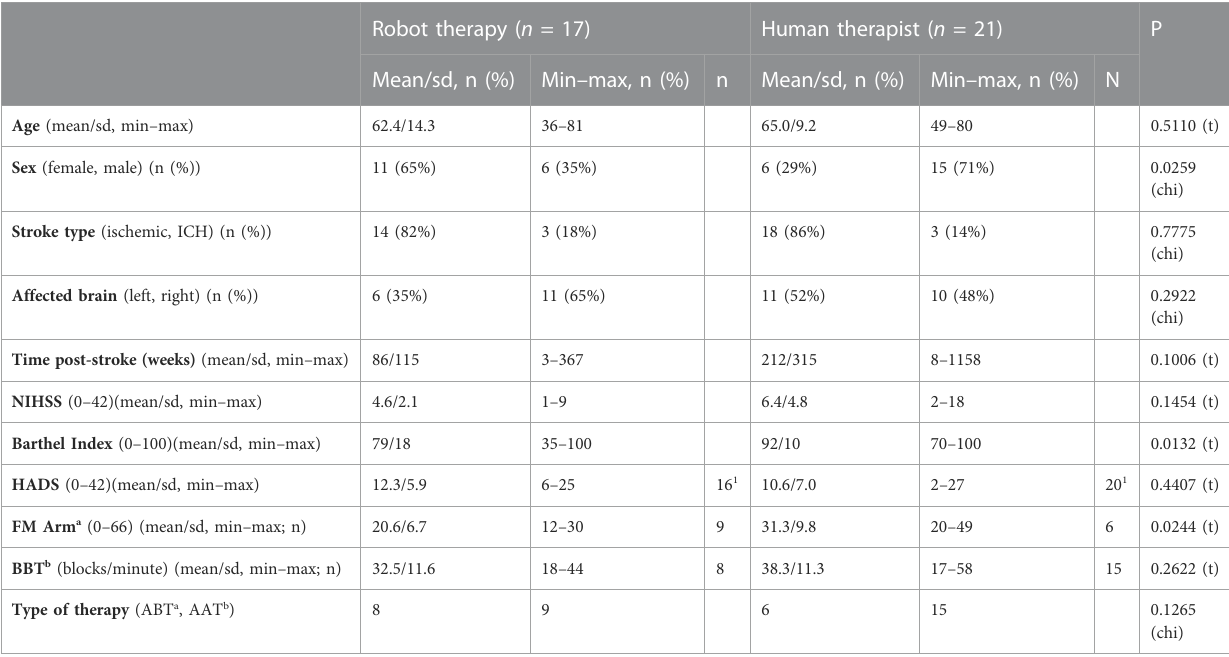
TABLE 1 Study population characteristics ( n =